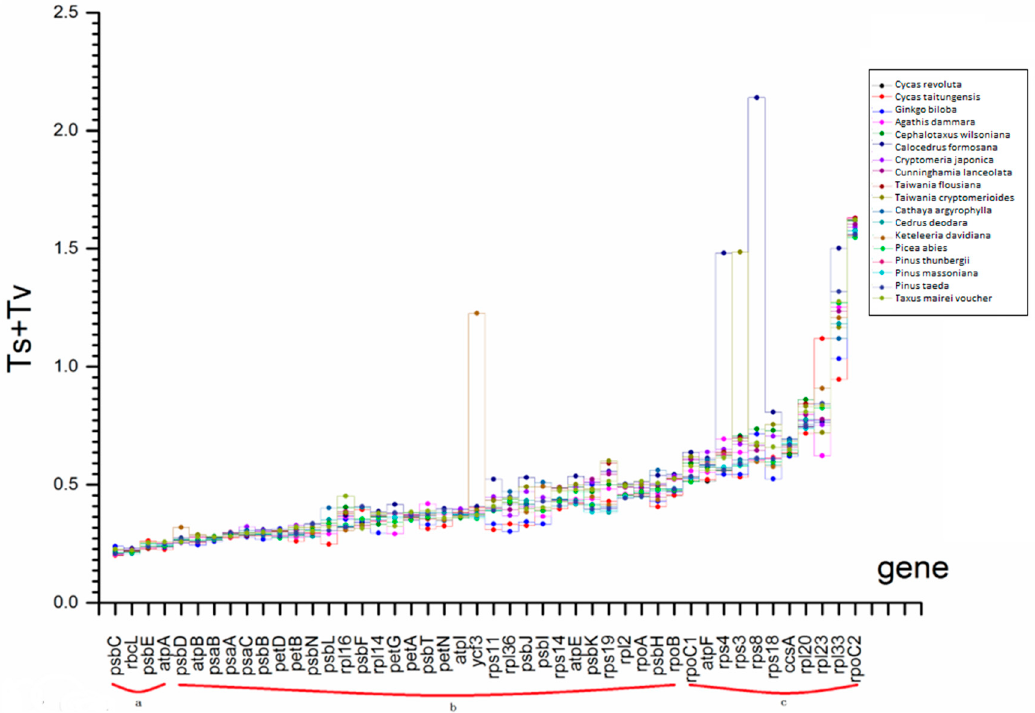
Figure 4. Comparison of the total nucleotide substitution rates (Ts + Tv) of the 46 common protein-coding genes in the 19-species matrix. The matrix consisted of 19 species including Selaginella moellendorffii and 18 gymnosperms. a, b and c represent Ts + Tv ranges groups according to the description in Section 3.6.